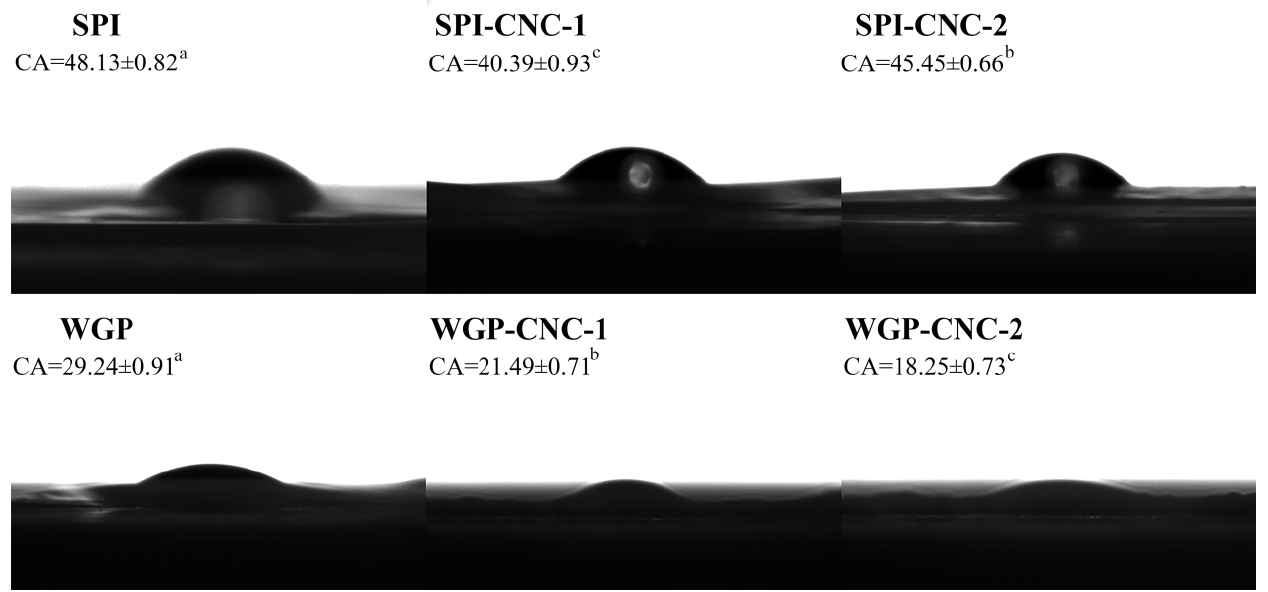
Figure 5. Water contact angle images on the surface of the SPI/WGP-based films. Different letters (a–c) indicated significant differences ( p <